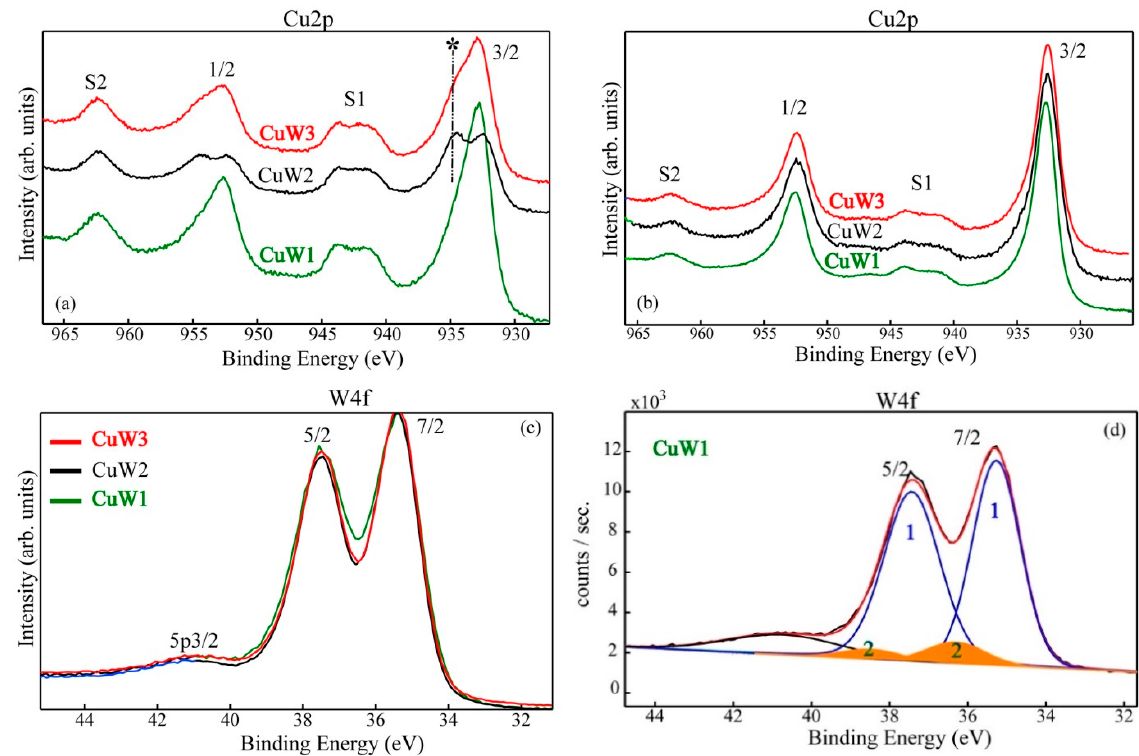
Figure 7. Cu2p and W4f high resolution superimposed spectra of CuW1, CuW2, and CuW3 in the “as received” stage ( a , c ), after a gentle surface Ar ion etching ( b ), and W4f deconvoluted spectrum for the CuW1 sample ( d ). The formation of CuOH on the top of the surface is marked with symbol * .